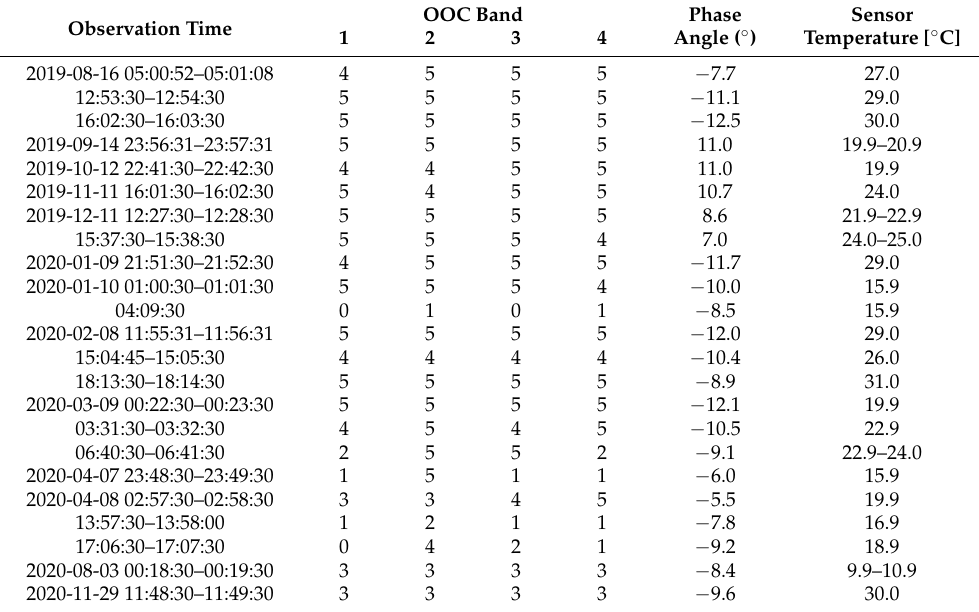
Table 2. Summary of the OOC’s Moon observations with phase angle and the sensor housing temperature listed for individual observation time. The number of obtained Moon images are indicated in the OOC band columns. Negative phase angles indicate a waxing